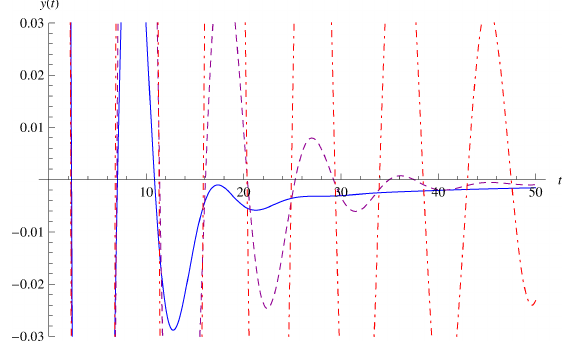
Fig. 9. Curves in Fig. 8 with different vertical scales.